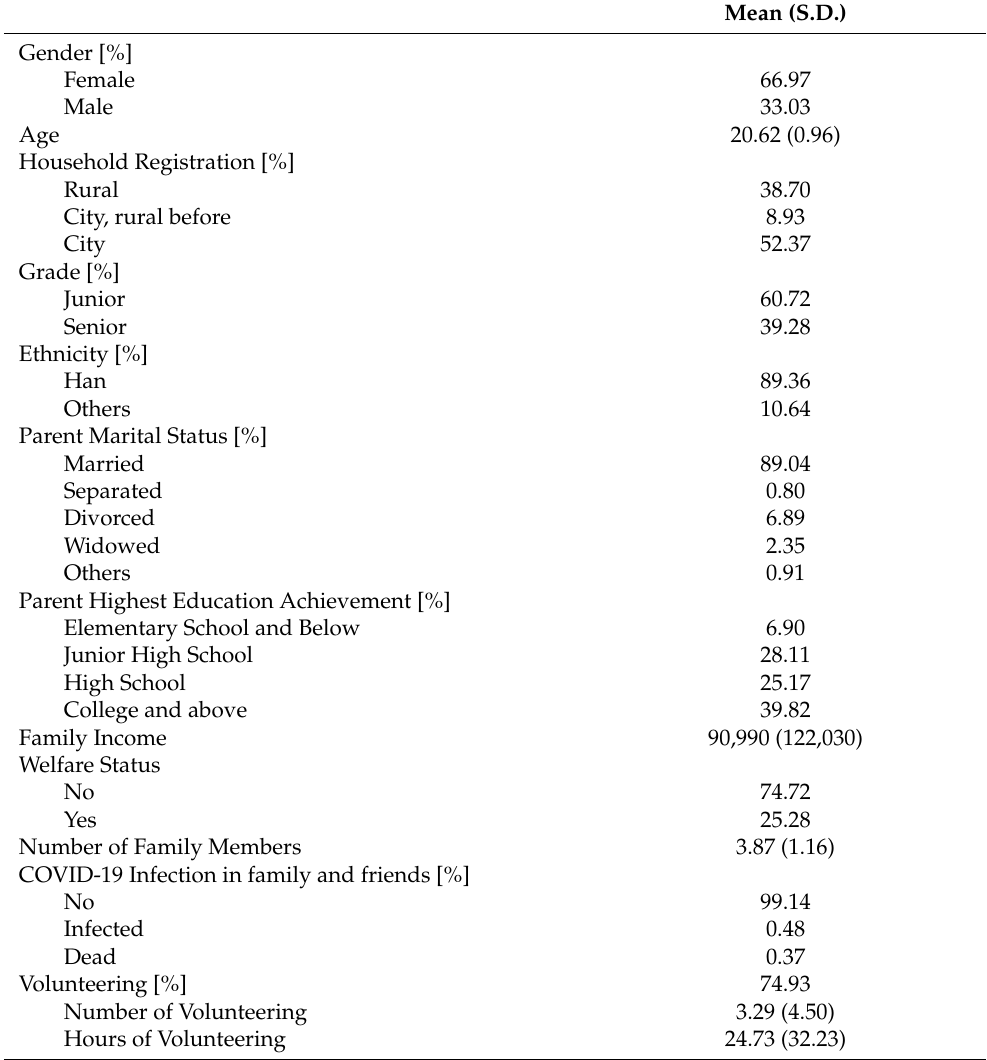
Table 1. Descriptive Statistics of Key Variables. Note: n = 1871.